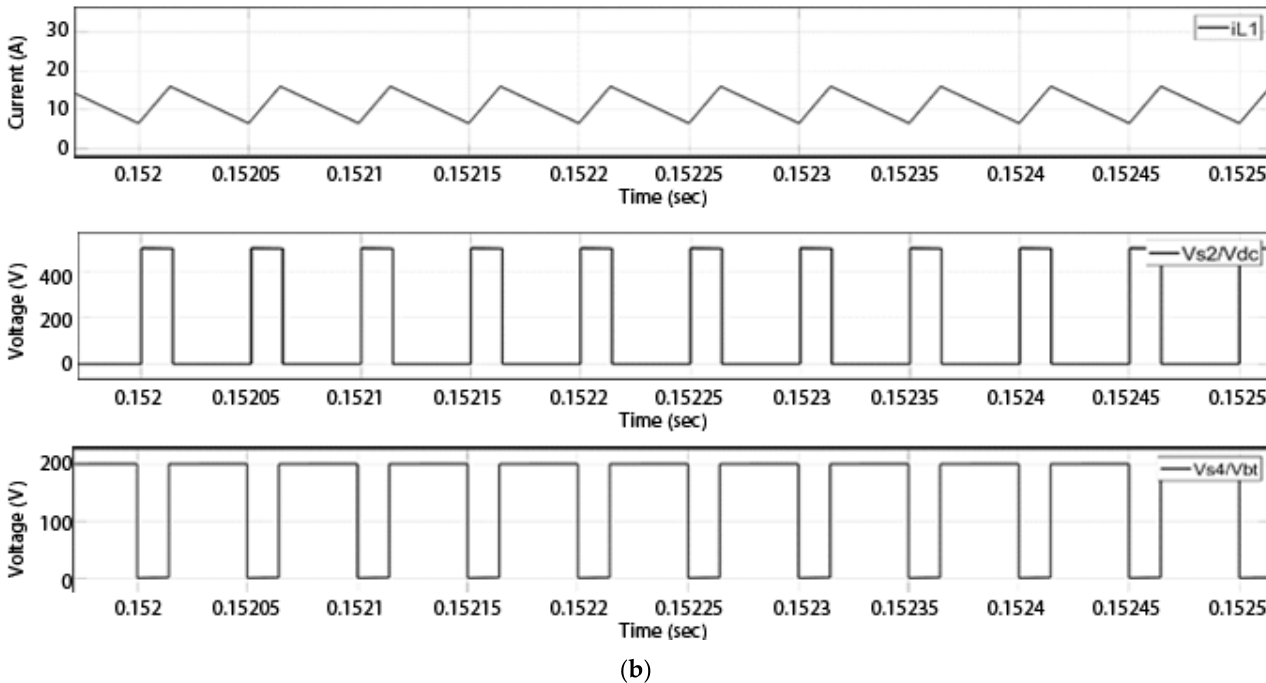
Figure 9. ( a ) Voltages of switches S 4 and S 2 and current of L 1 in mode 1(a). ( b ) Voltages of switches S 4 and S 2 and current of L 1 in mode 1(b).